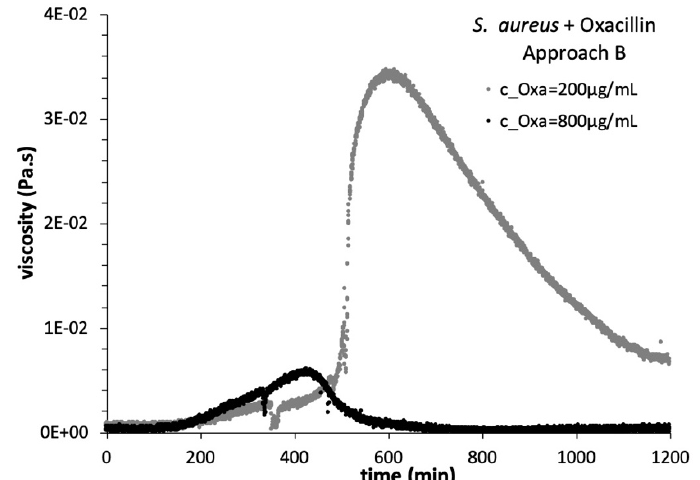
Figure 5. Viscosity growth curves for bacterial cultures of S. aureus , with the addition of the antibiotic oxacillin directly to the sample in the rheometer, approach B. The bacteriolytic antibiotic oxacillin was added at t = ~340 min for two concentrations: c_Oxa = 200 µ g / mL (full gray symbol) and c_Oxa = 800 µ g / mL (full black symbol); all measurements were performed at a constant shear rate of 10 s − 1 (representative curves) and at 37 ◦